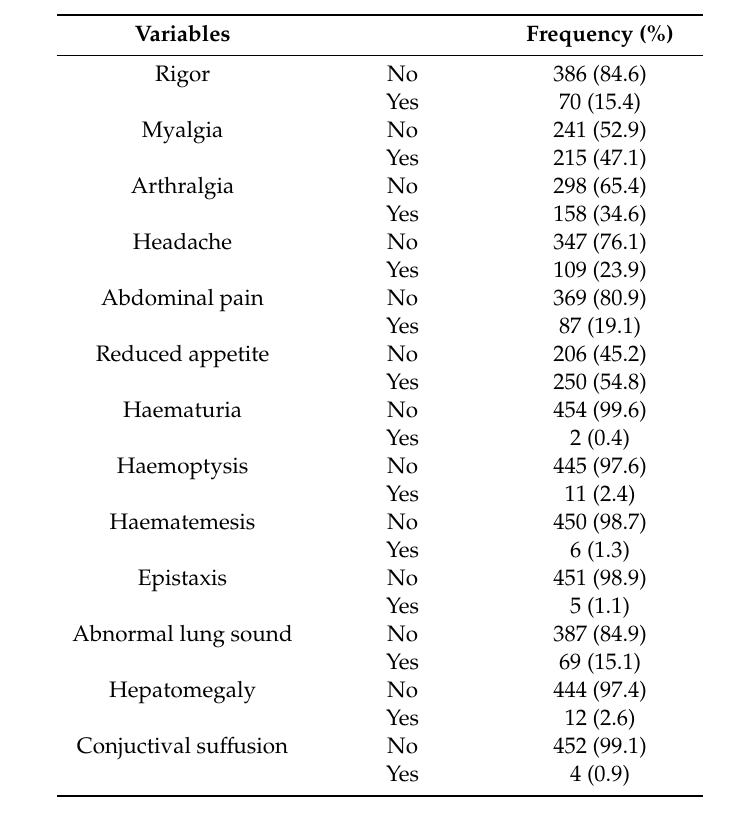
Table 3. Association between sociodemographic factors and signs with severe